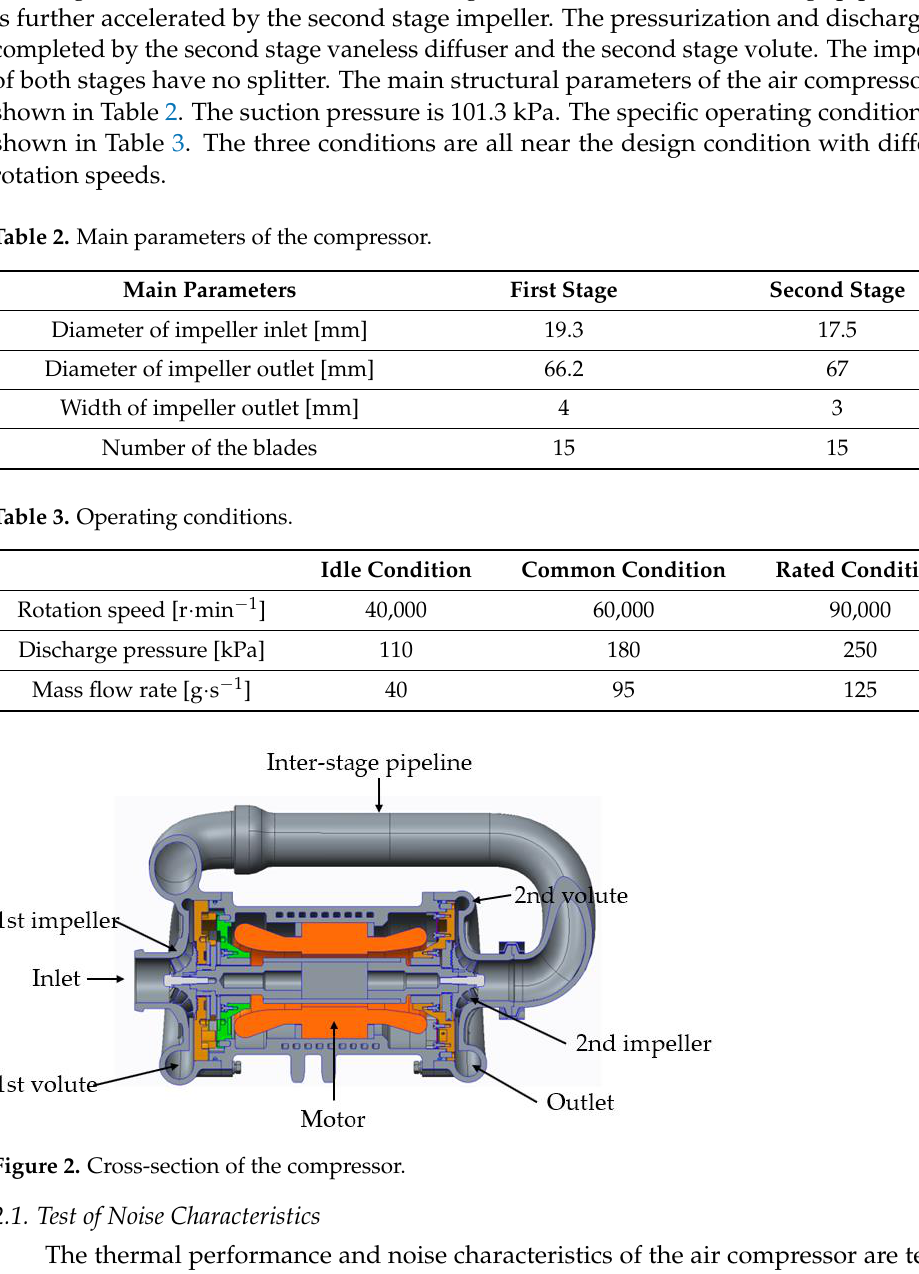
Figure 1. Schematic diagram of a typical hydrogen fuel cell system for vehicles.